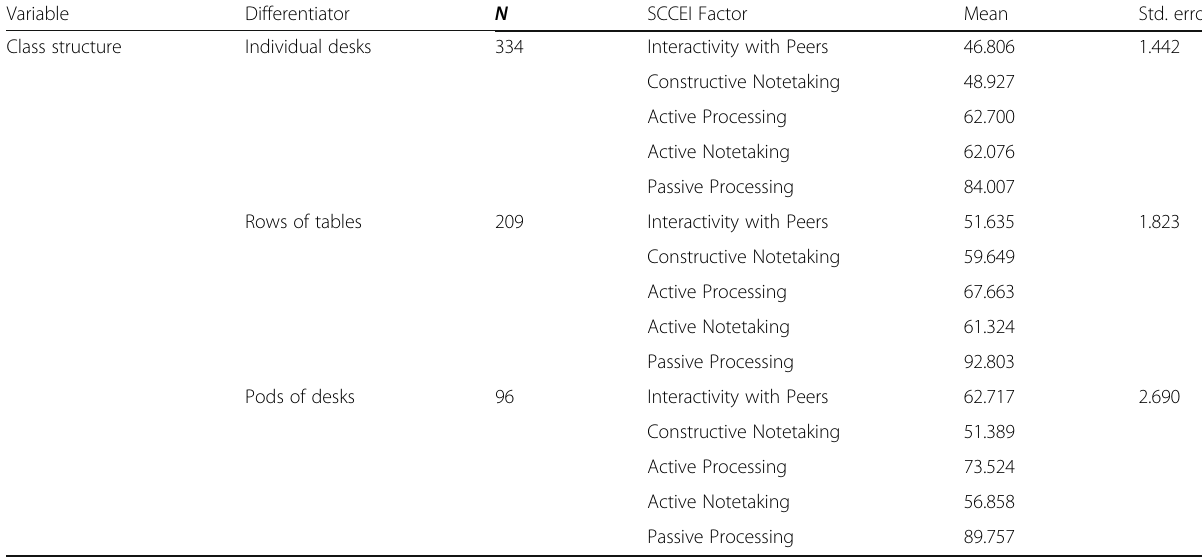
Table 6 Descriptive statistics of ANOVA datasets Variable